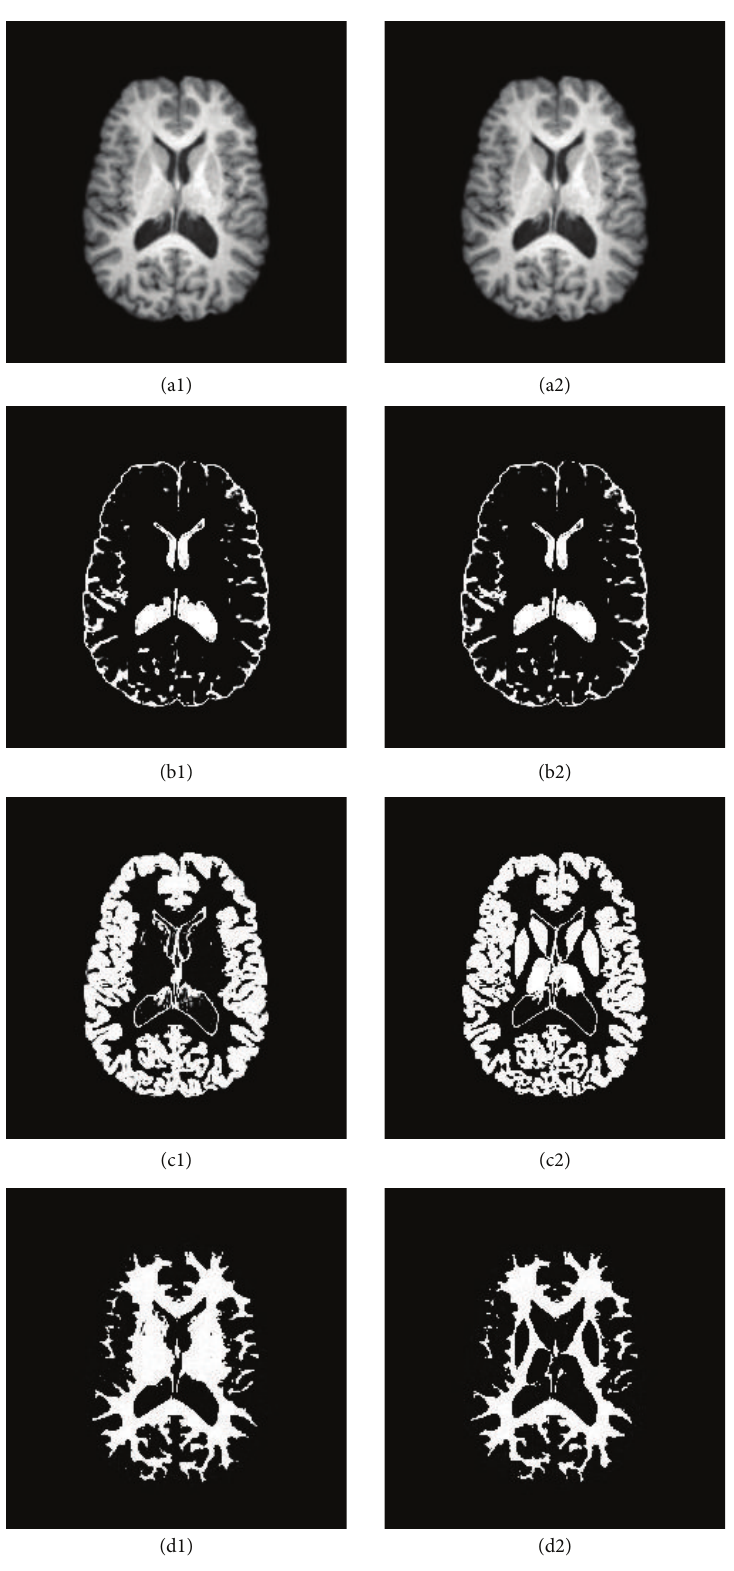
Figure 6: Comparison between unsupervised segmentation result and the ground